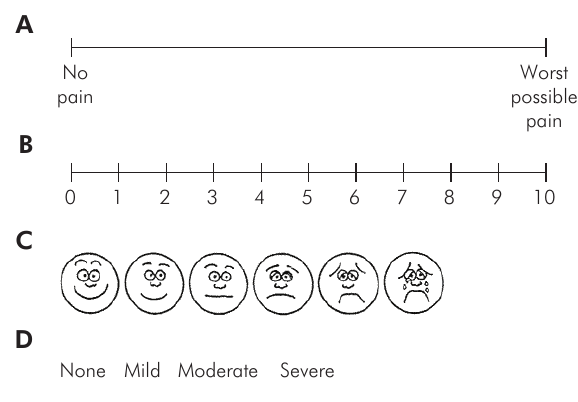
Figure 1. DH scales. A) Visual analogue scale B) Numeric scale C) Faces pain scale D) Verbal evaluation